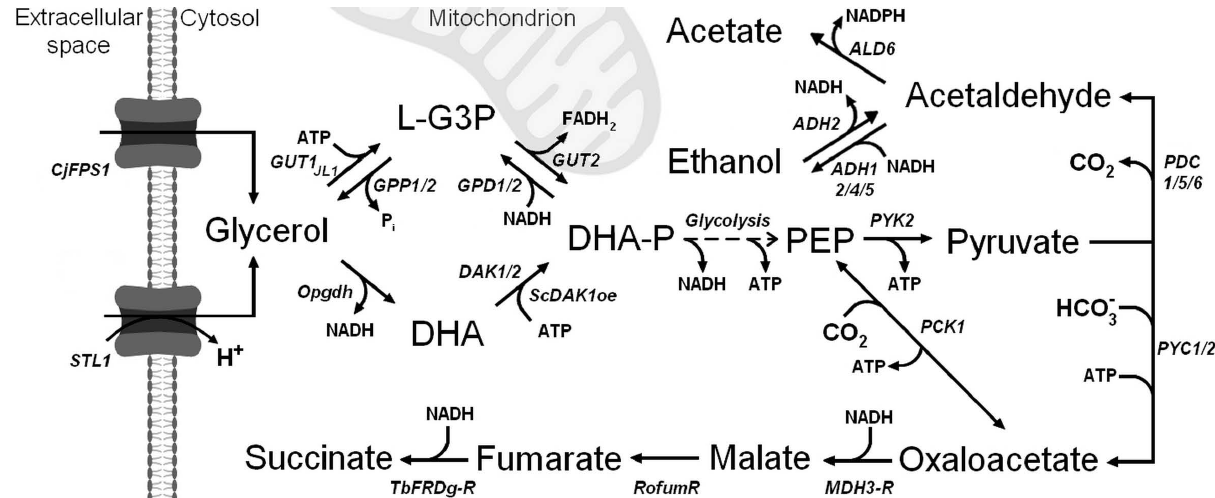
Figure 1. Overview of the central metabolism of the succinic acid overproducing Saccharomyces cerevisiae SA strain constructed in this study. This strain was used to study the impact of different transporters from the AceTr family in comparison to the Dct-02 transporter from A. niger on succinic acid transport. The strain was designed for the utilization of glycerol as the sole source of carbon. It does not contain any heterologous succinic acid transporters and shows a maximum extracellular succinic acid concentration of 13.9 g/L in shake flask cultivations (see main text). CjFPS1 : Cyberlind- nera jadinii FPS1 (aquaglyceroporin), STL1 : glycerol/H + symporter, GUT1 : glycerol kinase, GUT2 : FAD-dependent glycerol-3-phosphate dehydrogenase, GPP1/2 : glycerol-3-phosphate phosphatase, GPD1/2 : glycerol 3-phosphate dehydrogenase, Opgdh : NAD + -dependent glycerol dehydrogenase from Ogataea parapolymorpha , ScDAK1oe : overexpression of S. cerevisiae dihydroxyacetone kinase, DAK1/2: dihydroxyacetone kinase, PYK2 : pyruvate kinase, PCK1 : phosphoenolpyruvate carboxyki- nase, PYC1/2 : pyruvate carboxylase, MDH3-R : peroxisomal malate dehydrogenase targeted to the cytosol, RofumR : fumarase from Rhizopus oryzae , TbFRD-R : glycosomal fumarate reductase